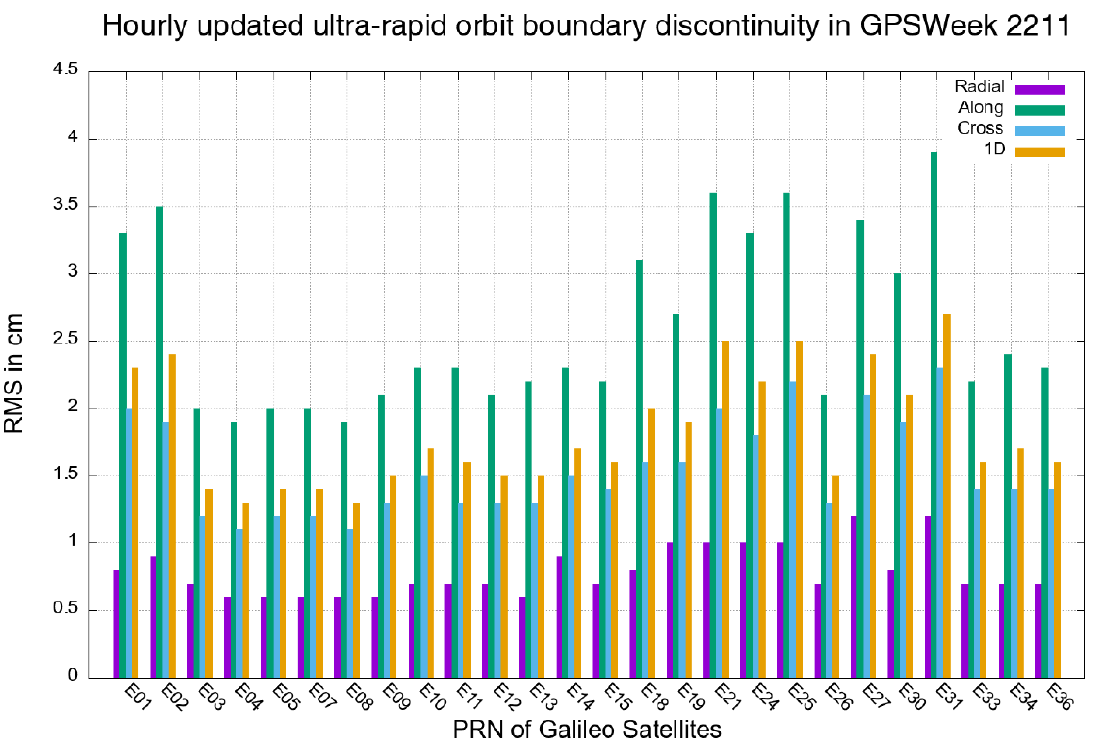
Figure 18. Mean RMS of overlapping in the RAC components and 1-D of Galileo satellites.